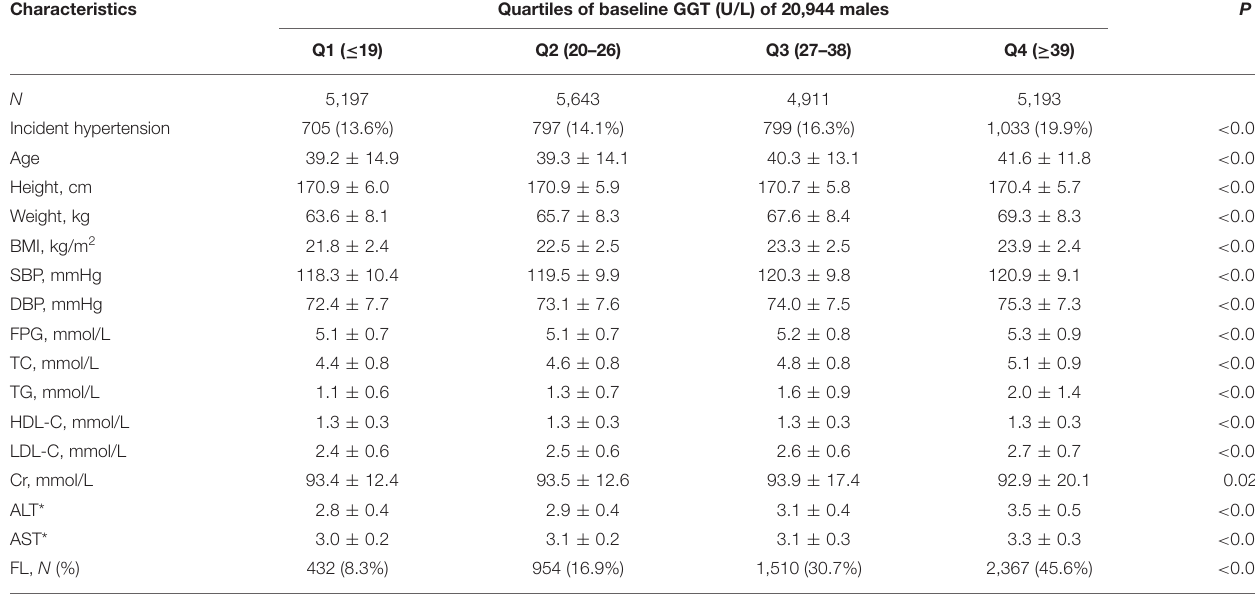
TABLE 1 | Baseline characteristics of included